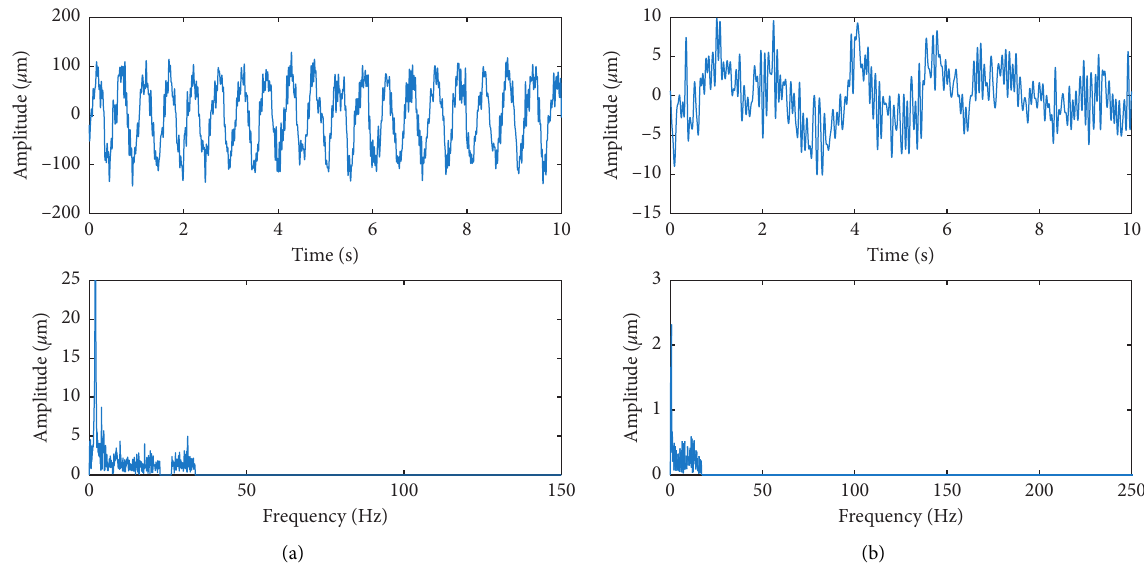
Figure 6: Actual signal processed by FDM. (a) Y -direction swing signal at the flange. (b) Vibration signal at the draft tube.